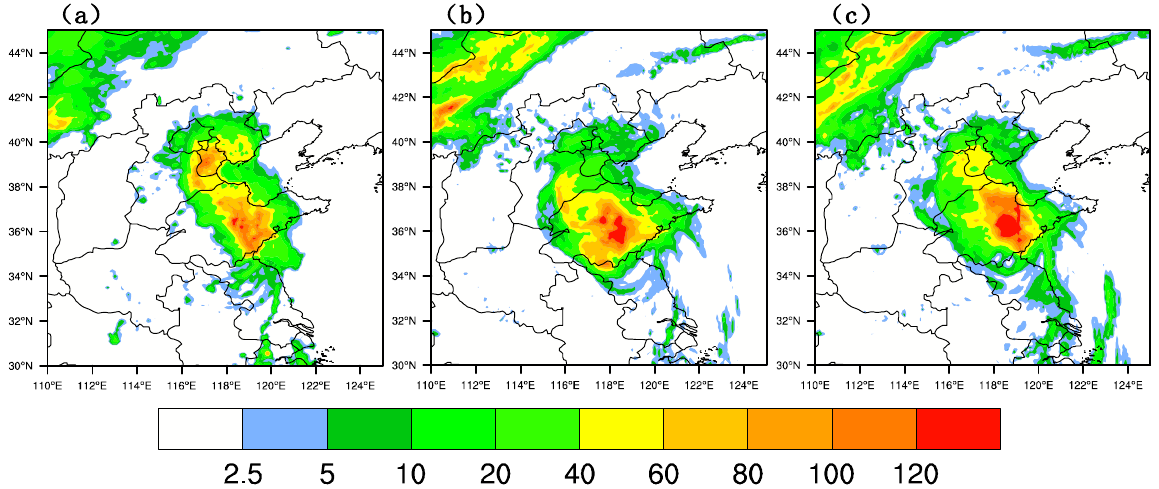
Figure 11. Twenty-four-hour precipitation distribution of ( a ) observation, ( b ) GTS, and ( c ) MWHS2.